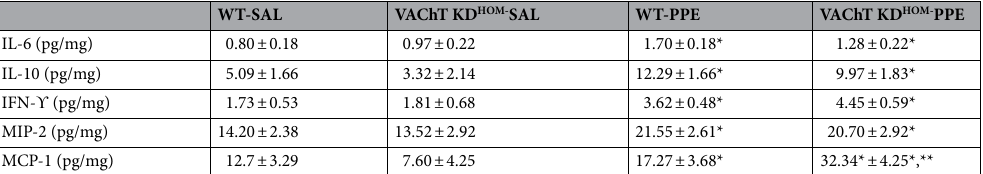
Table 1. The effects of reduction in VAChT levels on pulmonary cytokines. Data represent the mean ± S.E.M of four to five animals per group. The levels of IL-6, IL-10, IFN- ϒ , MCP-1 and MIP-2 (pg/mg) in lung homogenate were increased in animals submitted to the elastase protocol compared to the saline groups. MCP-1 levels were increased in VAChT KD HOM- PPE group compared to WT-PPE. *P < 0.05 compared to WT-SAL and VAChT KD HOM- SAL. **P < 0.05 compared to